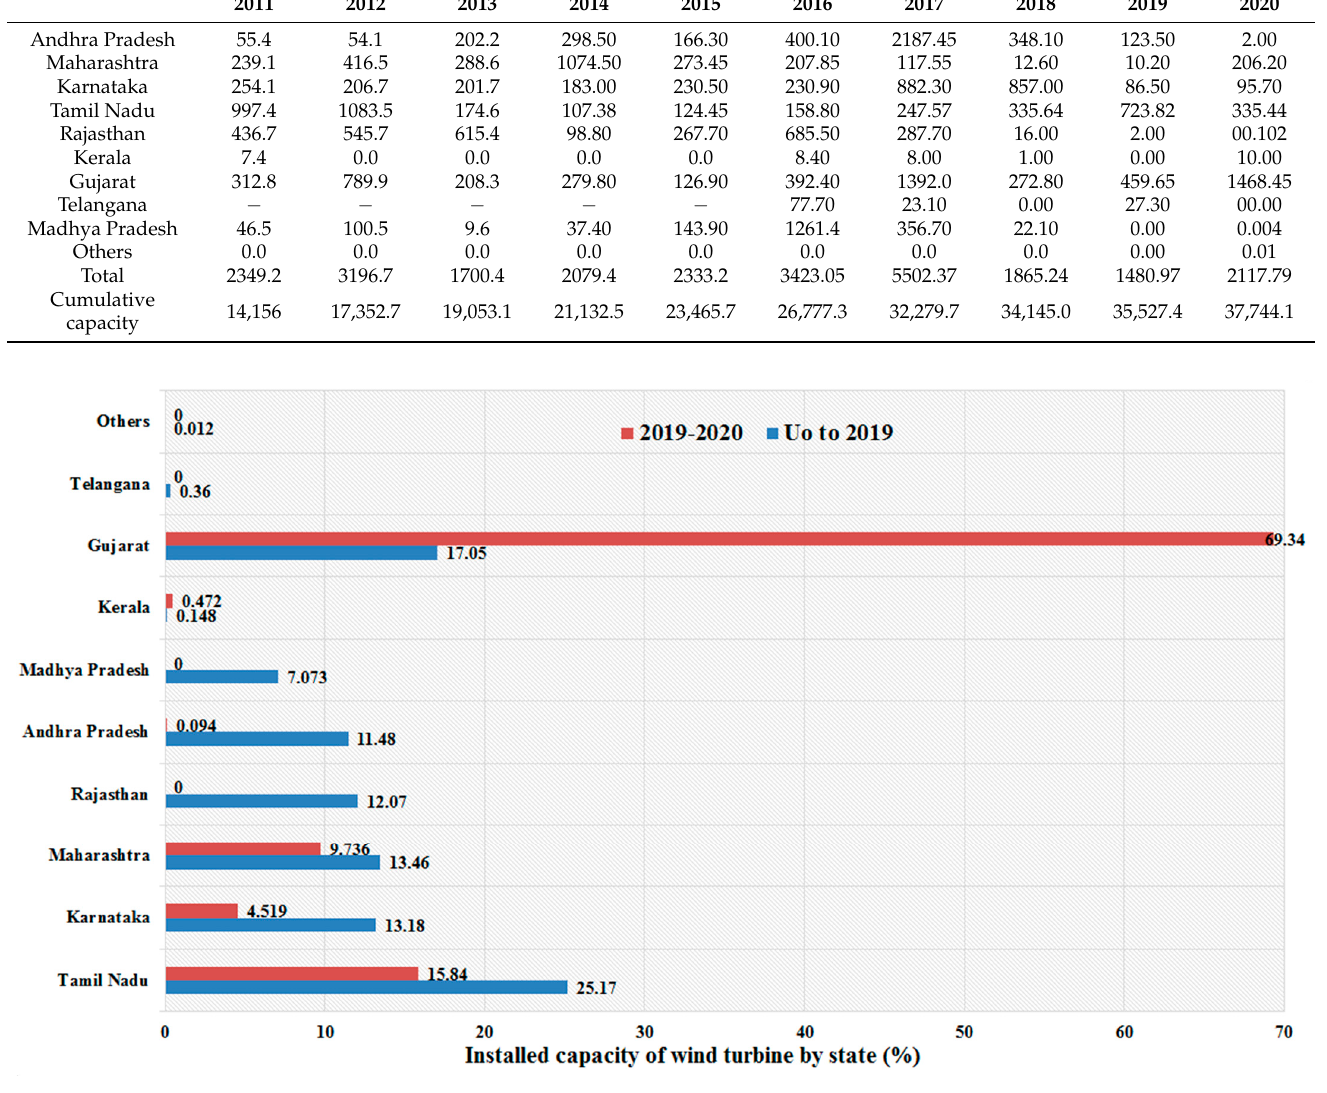
Figure 14. Percentage of installed capacity of wind turbine by state, in India (2019–2020) [60].